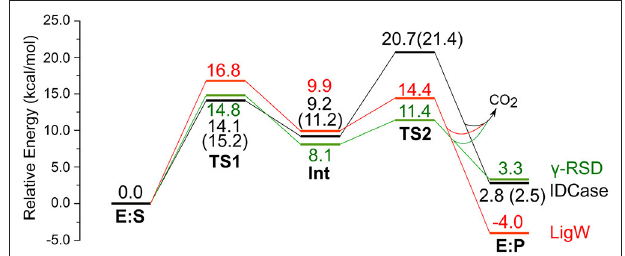
FIGURE 3 | Calculated energy profiles for the decarboxylation reactions catalyzed by IDCase (black), γ -RSD (green, values taken from Sheng et al., 2018) and LigW (red, values taken from Sheng et al., 2017). The energies for IDCase with Zn instead of Mn are given in parentheses.